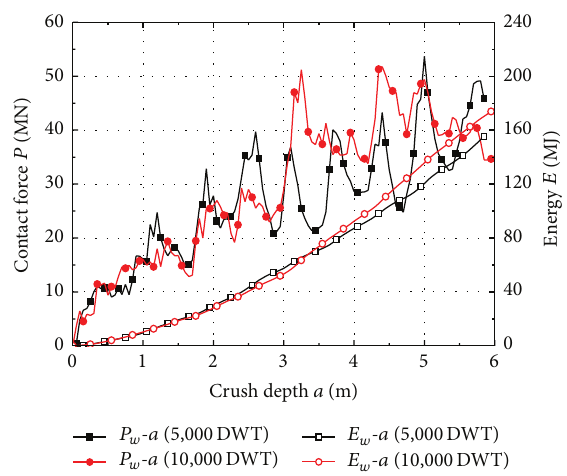
Figure 7: P-a curve versus 𝐸 𝑤 -a curve of ship